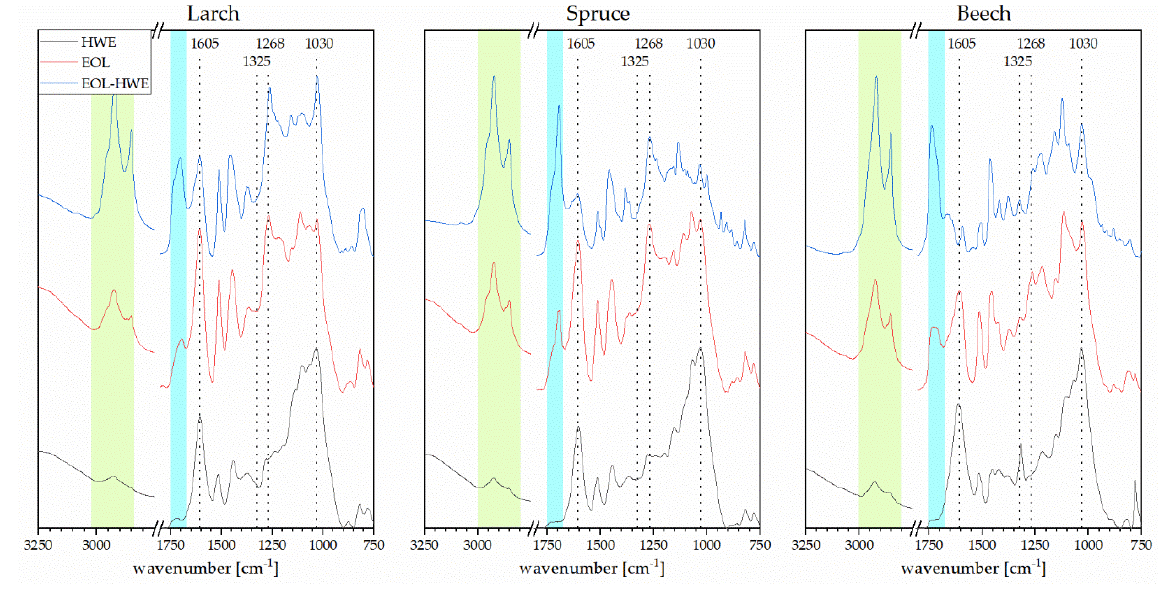
Figure 5. FTIR spectra of the obtained extracts.